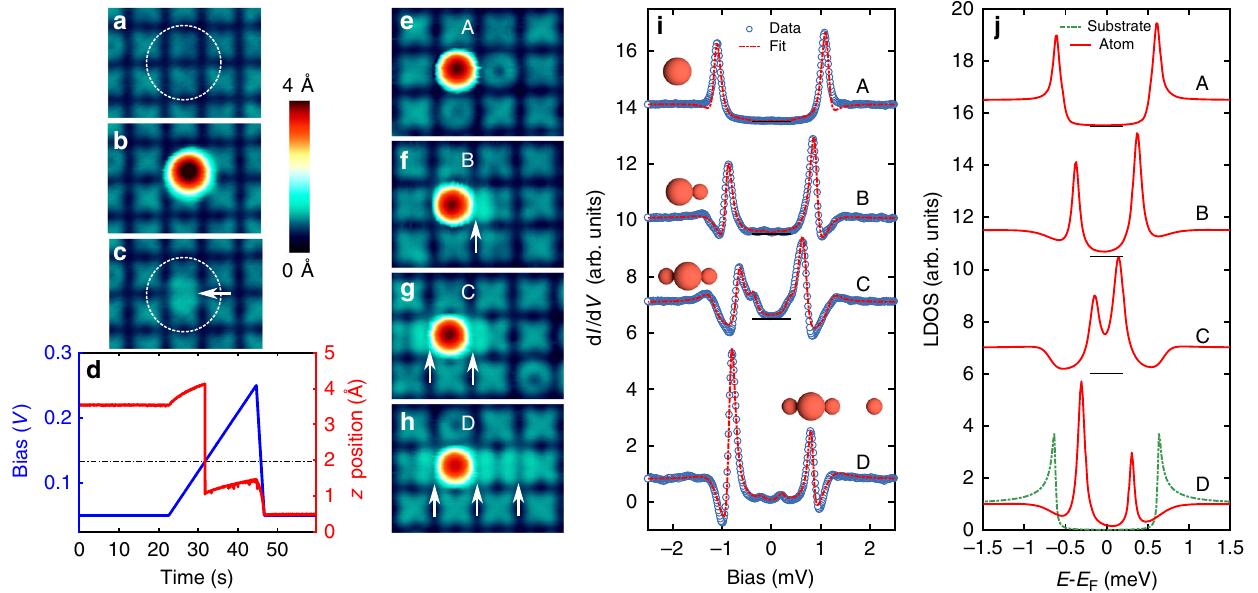
Fig. 3 Spectroscopy on adatoms coupled to interstitial Fe atoms (IFAs). a STM image of the area before the construction of the IFA. Dashed circle represents the target point. b STM image after vertical manipulation of an adatom to the target point. c Image after introducing the IFA into the target site. d Bias voltage and z position of the tip as a function of time during the manipulation of the Fe from the position in b to the interstitial site in c . Horizontal dashed line indicates the bias value, V = 130 mV, at which the Fe adatom relaxes into the interstitial site. e – h STM image of adatoms with no ( a ), one ( b ), two ( c ) and three ( d ) IFAs in close proximity. Here, the white arrows represent the positions of IFAs. i d I /d V spectra taken with a superconducting tip along with the fi t using numerical deconvolution corresponding to the adatoms shown in e – h . Spectra are shifted vertically for clarity. The pictograms indicate the positions of adatoms (large spheres) and IFAs (small spheres). j Numerically deconvoluted local density of states (LDOS) corresponding to the fi ts in i . Substrate density of states is plotted as reference. Stabilization parameters for STS: V parameters: V = 50 mV, I = 100